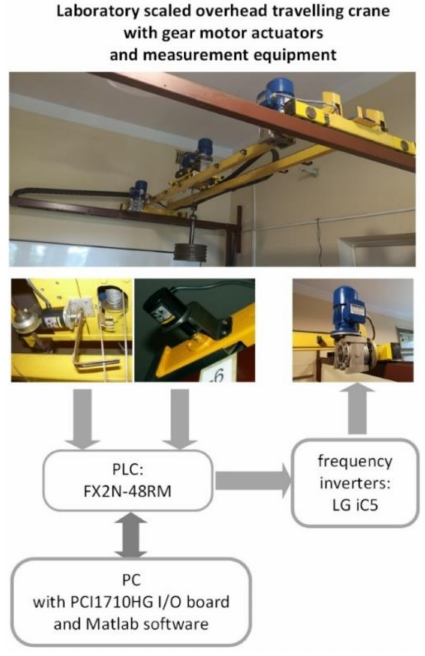
Figure 11. The laboratory